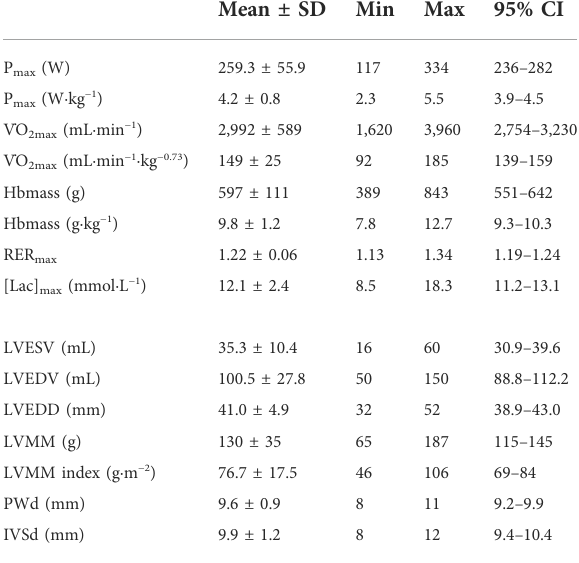
TABLE 2 Performance, hemoglobin mass and cardiological